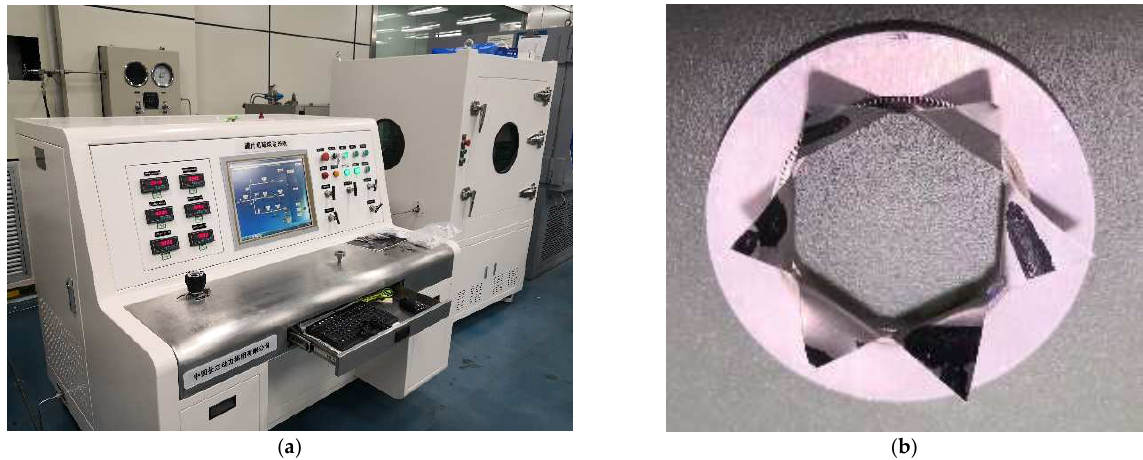
Figure 10. Bursting test for discs: ( a ) bursting test device and ( b ) bursting results. Table 2. Results of bursting test.